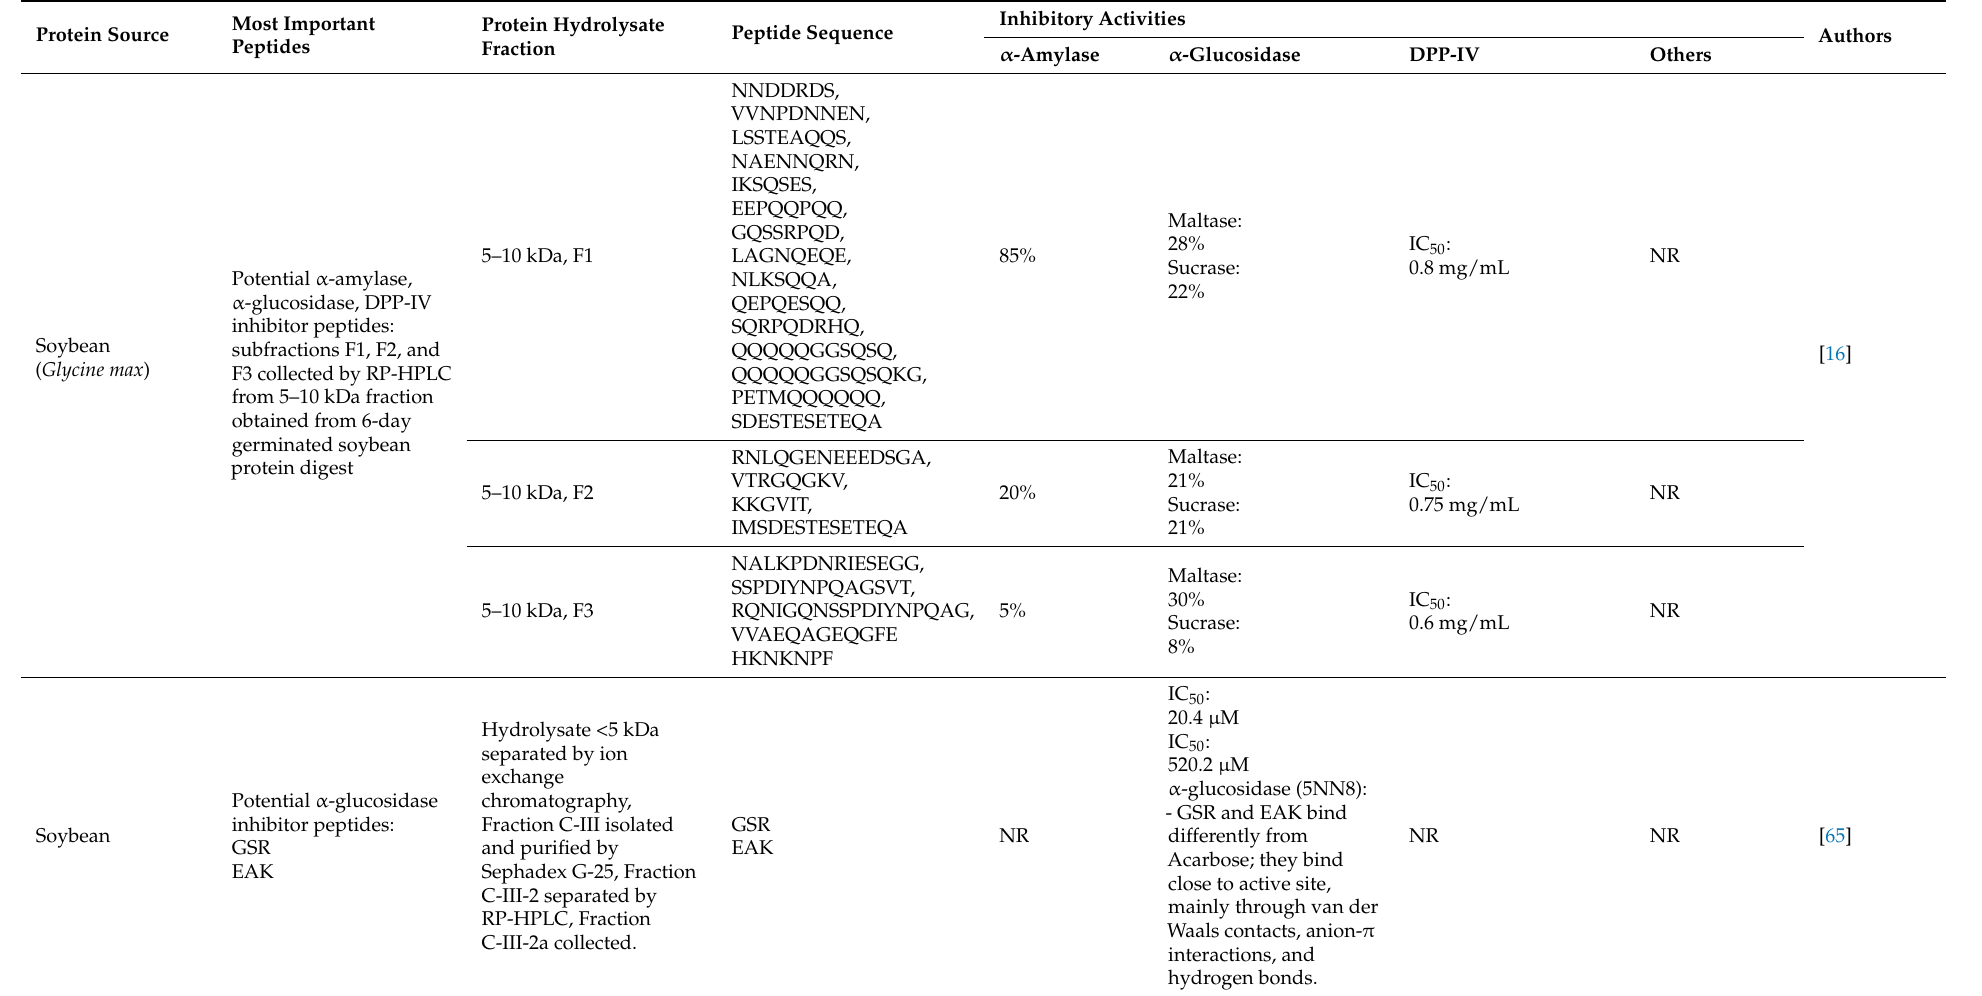
Table 9. Antidiabetic enzyme inhibitory activity of leguminous protein hydrolysate fractions and peptide sequences. Most Important Protein Hydrolysate Protein Source Peptides